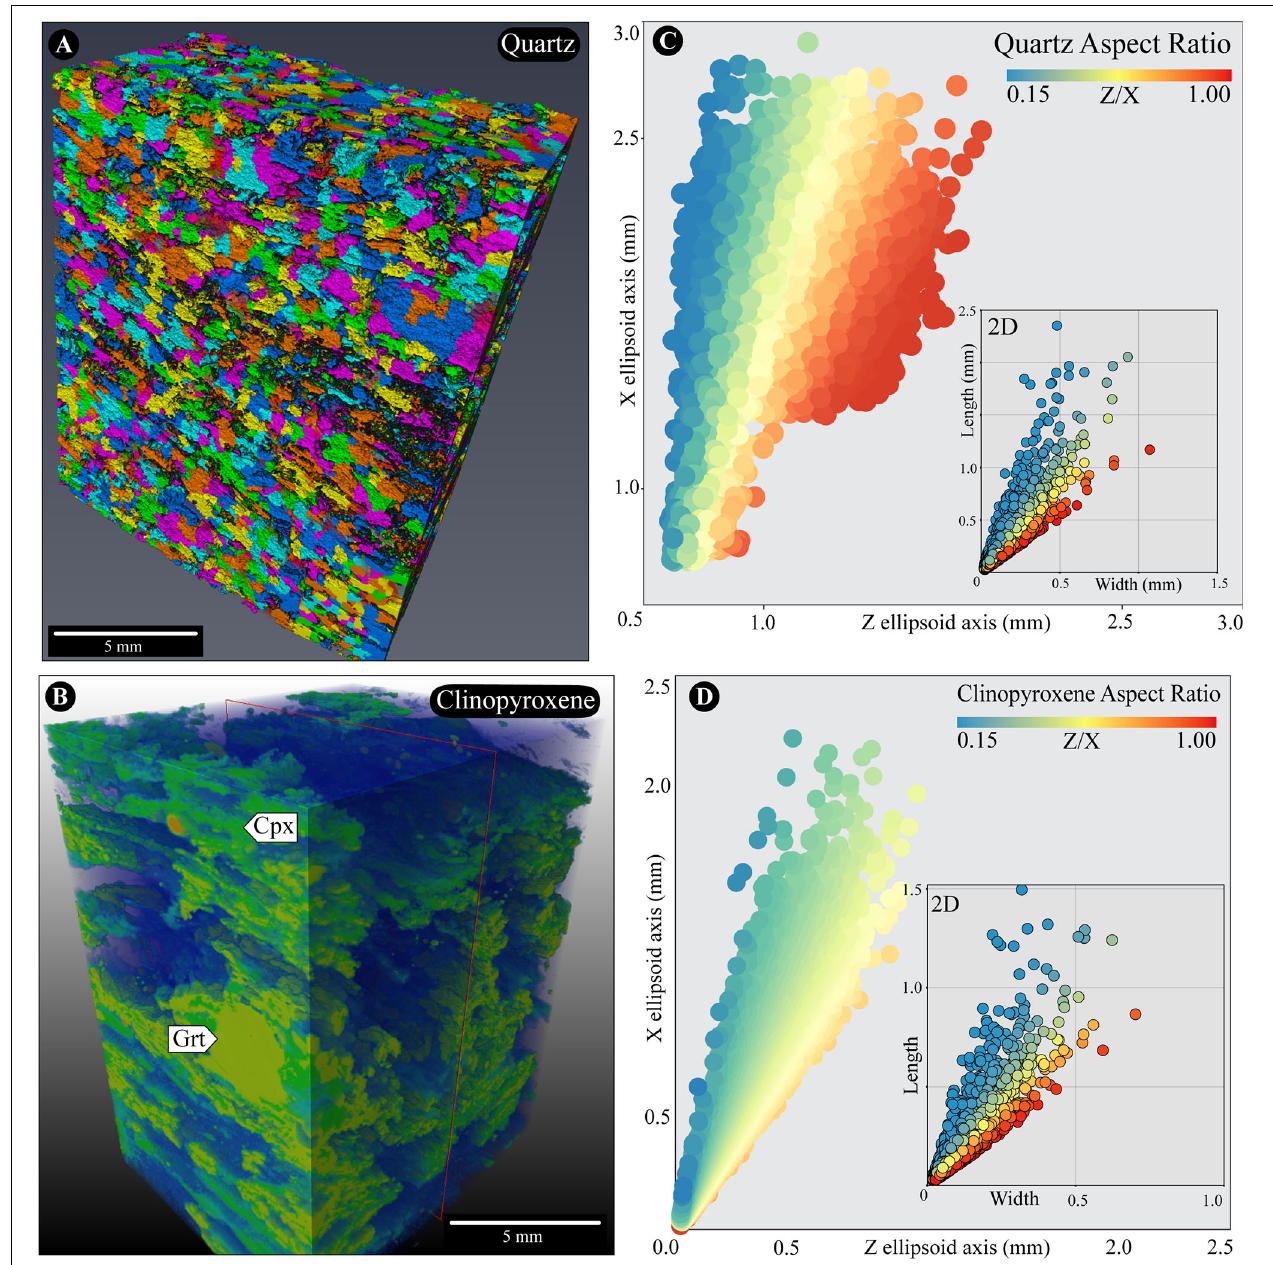
FIGURE 12 | (A) 3D visualization of the Qtz pseudo-grains arrangement. (C) Qtz aspect ratio plot defined by the Z ellipsoid axis and X ellipsoid axis ratio. The 2D aspect ratio plot is reported. (B) 3D visualization of the Grt (yellow), Qtz (blue), and Cpx (green) relationships. (D) Cpx aspect ratio plot defined by the Z ellipsoid axis and X ellipsoid axis ratio. The 2D aspect ratio plot is